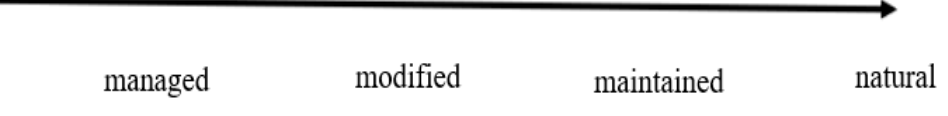
Figure 1. Adopted from Collins & Carson [2]. The participation context in action and adventure